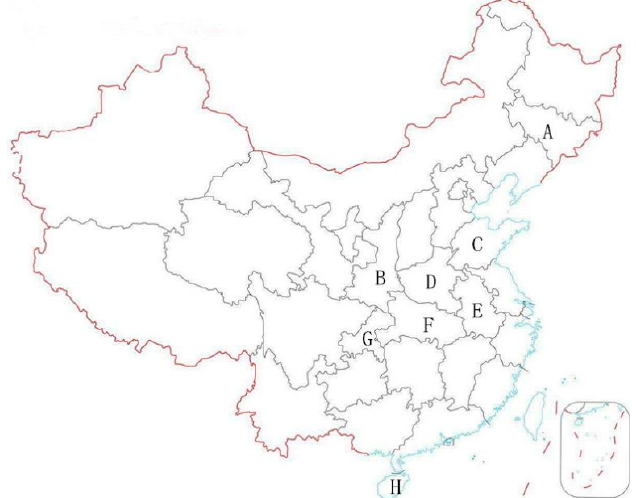
Figure 2. Location of the region of the sample collected in China: A—Jilin Province; B—Shanxi Province; C—Shandong Province; D—Henan Province; E—Anhui Province; F—Hubei Province; G—Chongqing Province; H—Hainan Province.